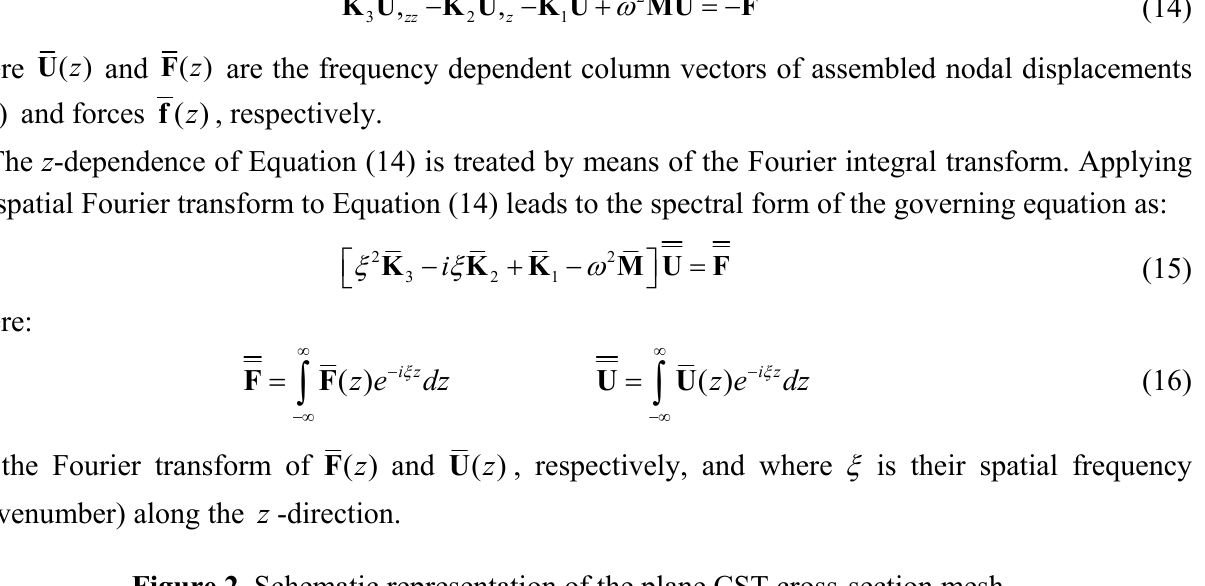
Figure 2 . Schematic representation of the plane CST cross-section